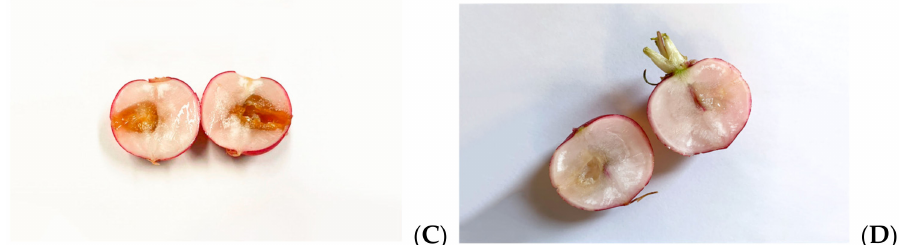
Figure 5. Effects of MOEs in infected radishes: ( A ) control, ( B ) HA-MOE, ( C ) HAMD-MOE, ( D ) MeOH-MOE.